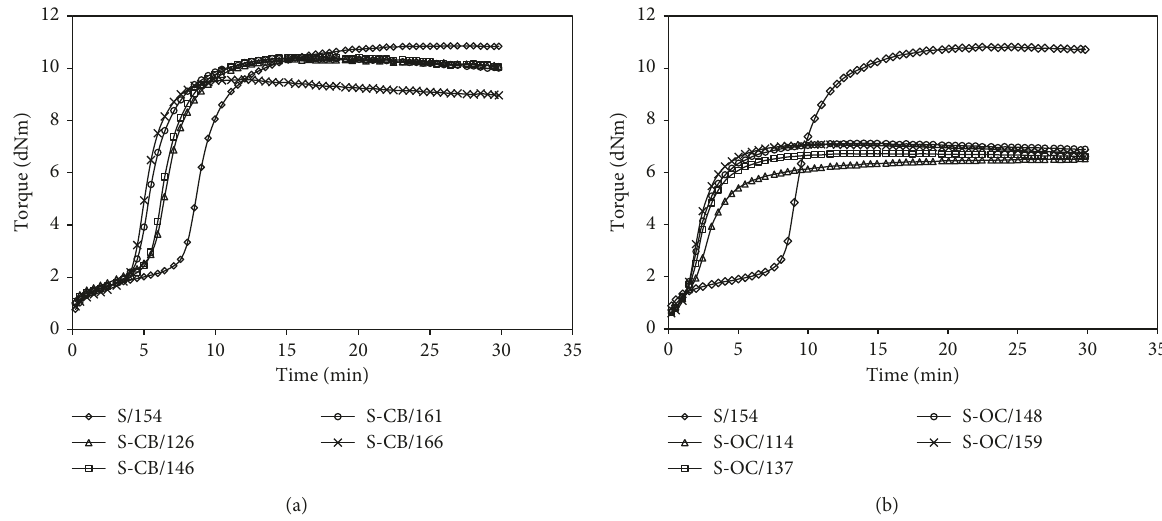
Figure 3: Effect of secondary fillers on cure characteristics of silica-filled NR compounds: (a) carbon black (CB) and (b) organoclay (OC). Dump temperatures are indicated in curve designations.